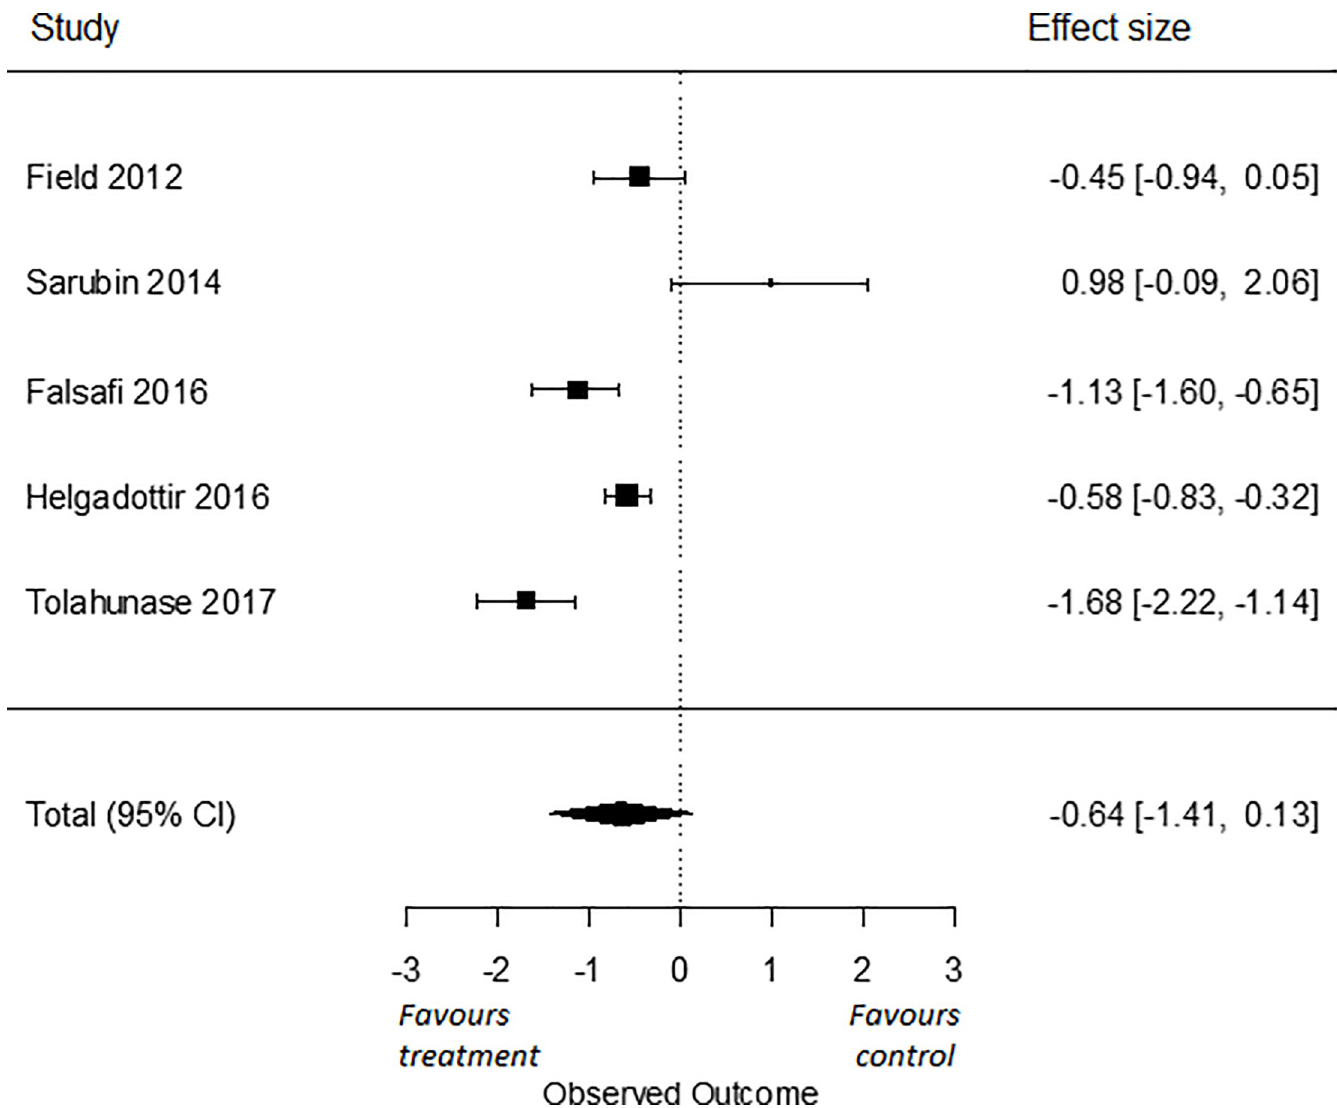
Fig 5. Effect of yoga versus TAU on depressive